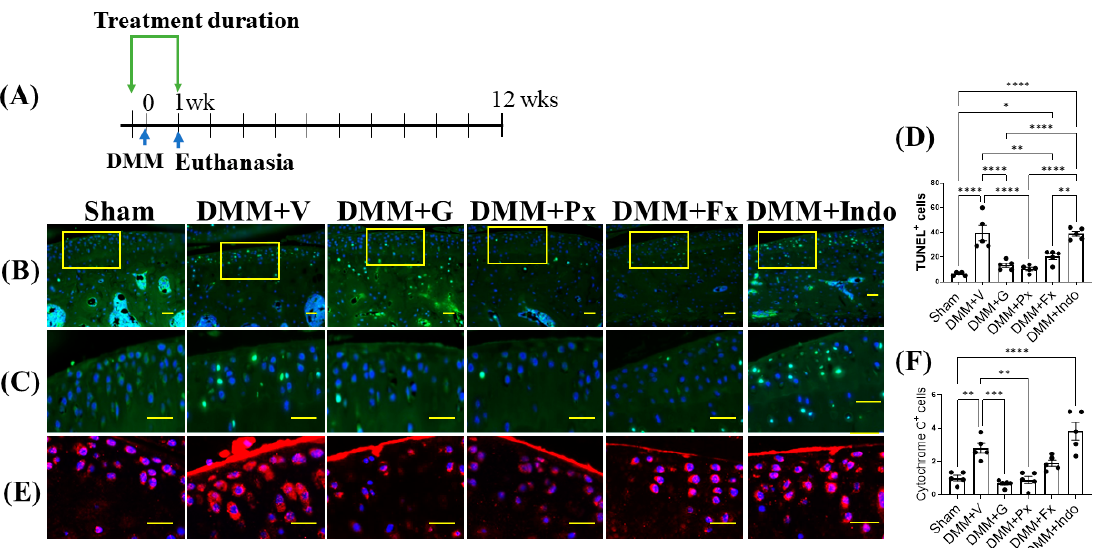
Figure 2. Early continuous G βγ -GRK2 inhibition reduces chondrocyte apoptosis and cytochrome C expression in mouse early PTOA cartilage. ( A ) Schematic representation of timeline of drug treatment after sham ( n = 5) or DMM surgeries. Two days before surgery, mice started receiving daily intraperitoneal injections of vehicle (V; n = 10), gallein (G; 10 mg/kg per day, n = 10), paroxetine (Px; 5 mg/kg per day, n = 7), fluoxetine (Fx; 5 mg/kg per day, n = 9), or indomethacin (Indo; 2.5 mg/kg per day, n = 9). All mice were euthanized 1 week after surgery. Green arrows denote the duration of drug treatment. Representative images showing fluorescent staining in the anterior femoral synovium: ( B ) TUNEL staining of apoptotic cells; scale bar, 50 µm. ( C ) Magnified images of regions marked by yellow boxes in ( B ); scale bar, 10 µm. ( D ) Quantification of TUNEL-positive cells. ( E ) IF staining of cytochrome C (red); scale bar, 10 µm. ( F ) Quantification of the percentage of cytochrome-C-positive cells. DAPI (blue) stains nuclei. n = 5 per group; * p < 0.05, ** p < 0.01, *** p < 0.001, and **** p < 0.0001 in 1 week treatment groups using one-way ANOVA. Values are expressed as means ± SEM.